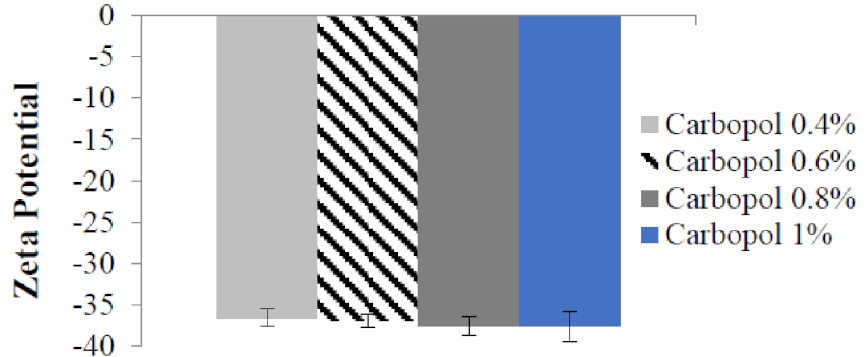
Figure 3. The zeta potential of Benzoyl peroxide nanoemulgel with different Carbopol concentrations.